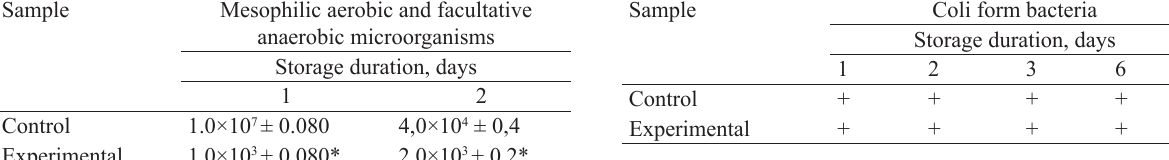
Table 10 Total bacterial count in carp during storage Sample